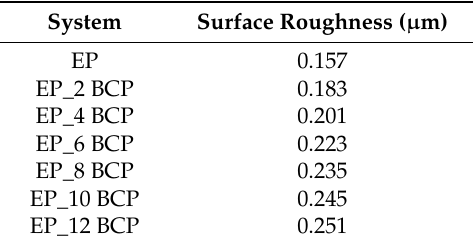
Table 5. Surface roughness values of compact tension (CT) fractured samples for different EP_BCP systems measured from white light